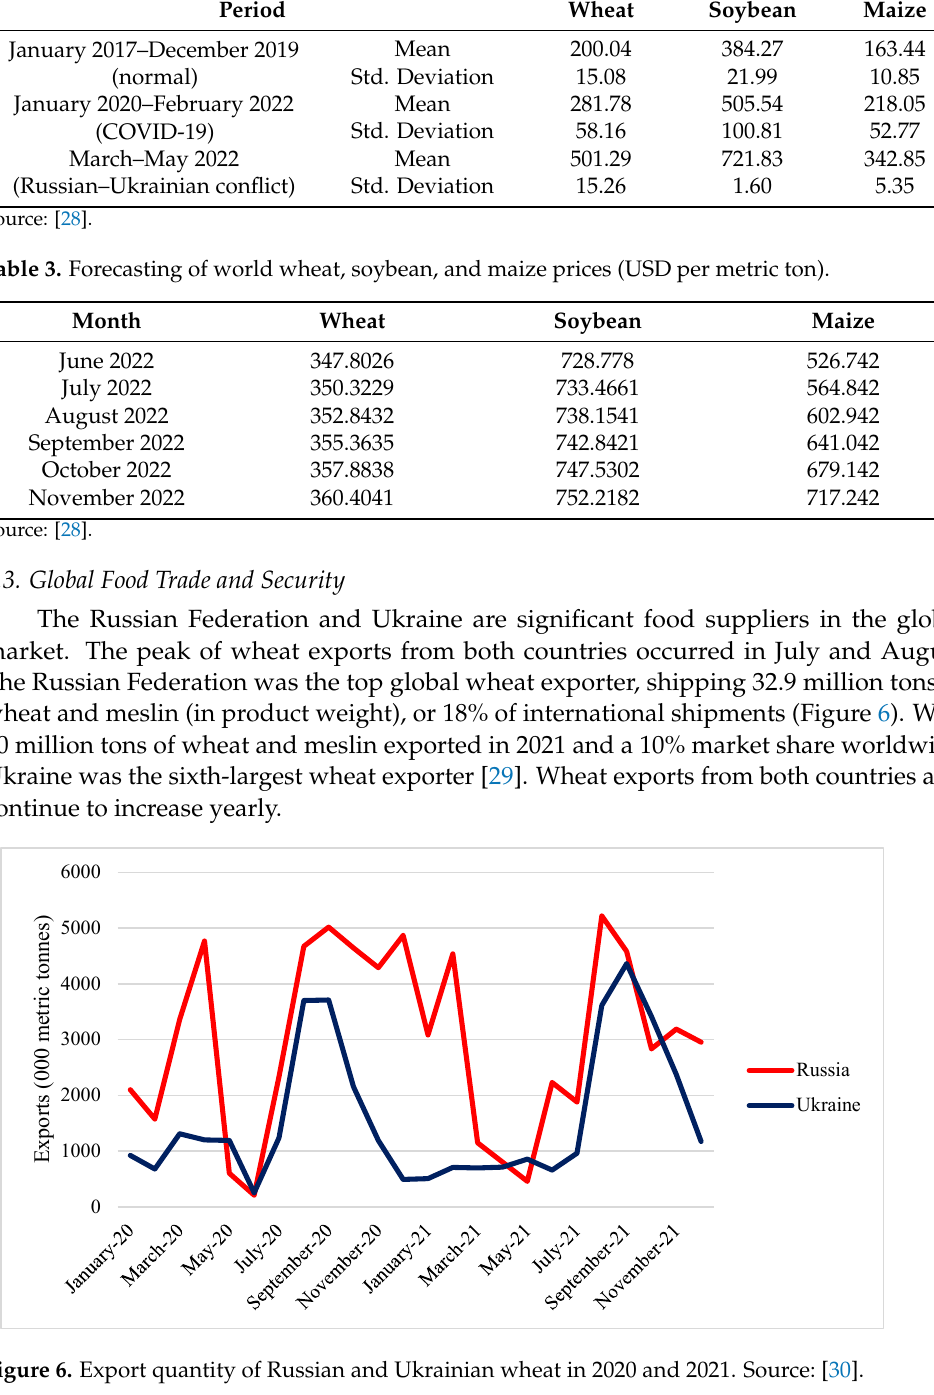
Table 2. Mean and standard deviation of world wheat, soybean, and maize prices (USD per metric ton).